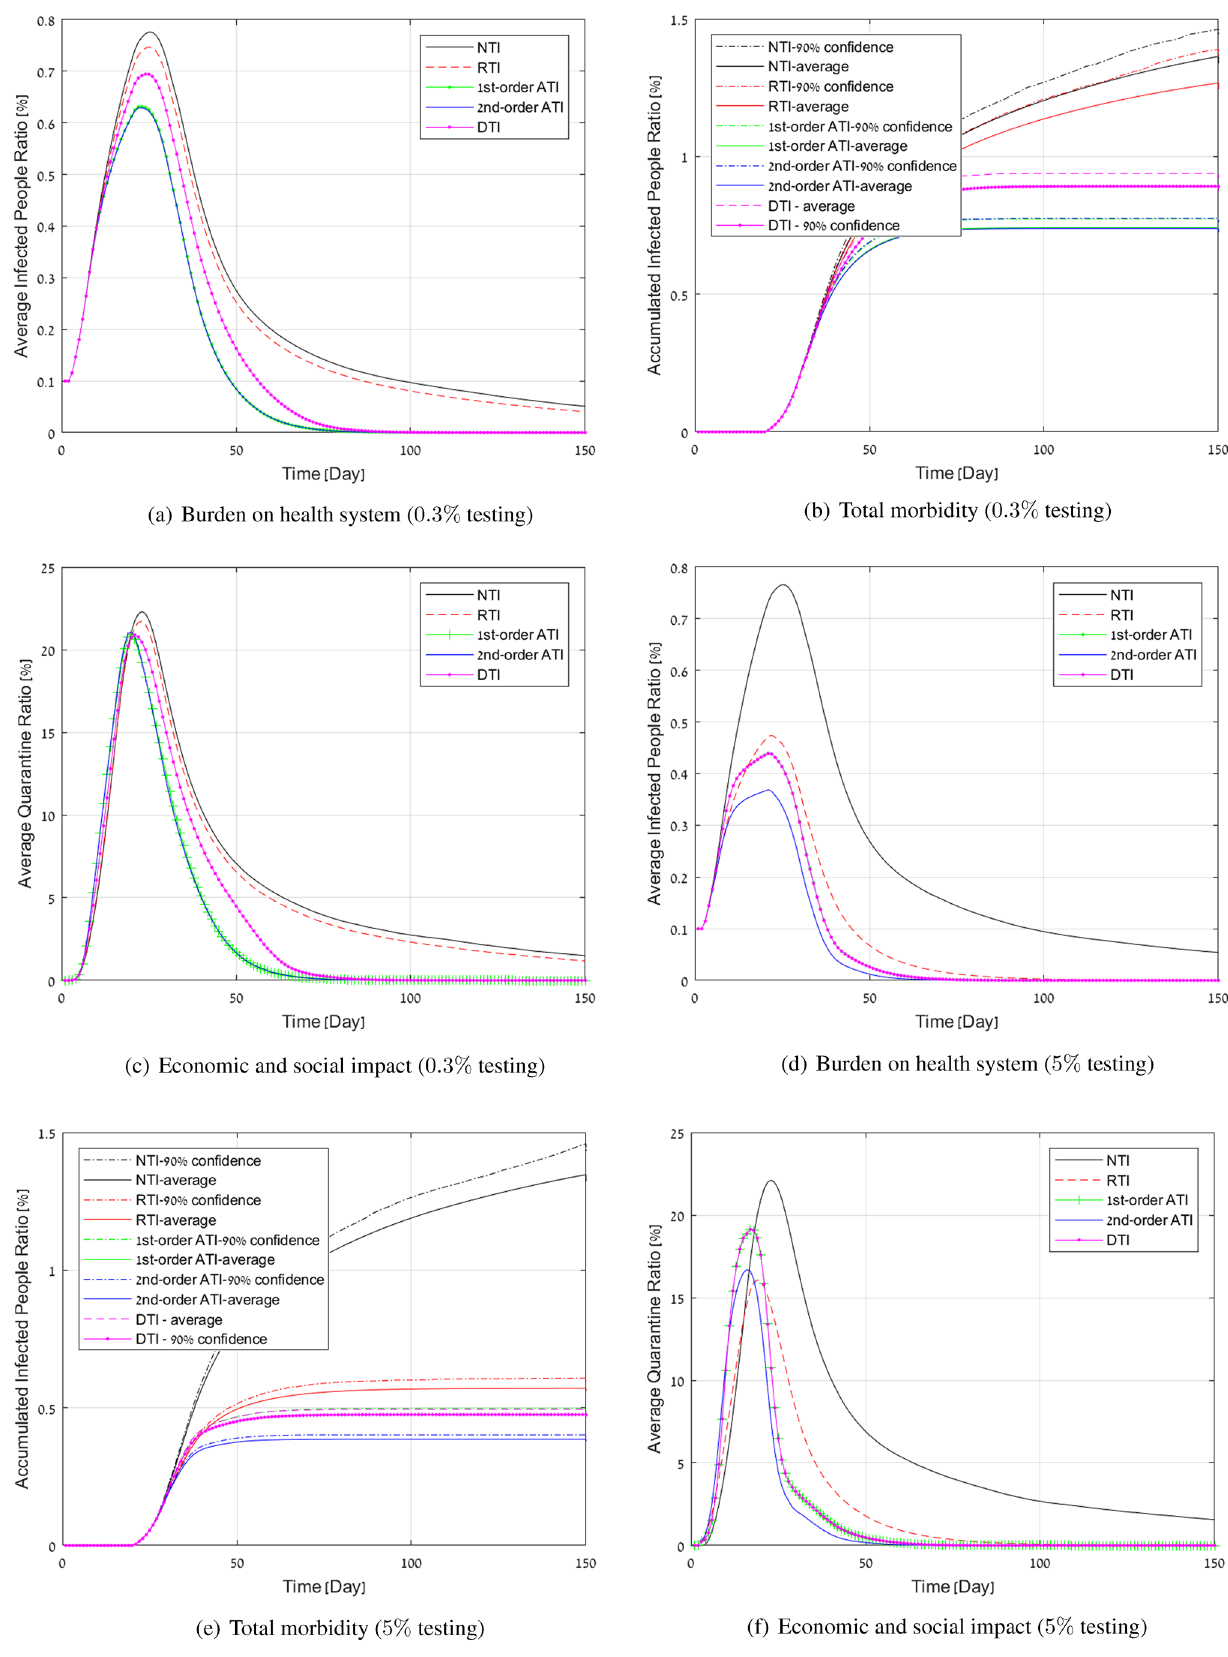
Figure 3. Simulation results for a COVID-19 outbreak in a population of 1 million people. Daily testing capacity ( 0.3, 5%